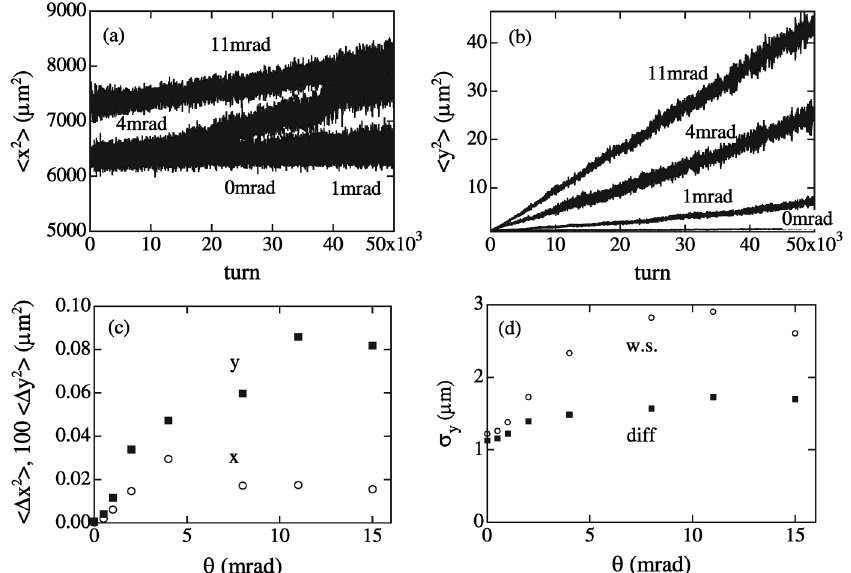
FIG. 5. Diffusion of horizontal and vertical beam size due to crossing angle. (a),(b) depict evolutions of horizontal and vertical beam sizes, respectively. (c) depicts the horizontal and vertical diffusion rates. (d) depicts vertical beam sizes, which are estimated by the diffusion rate (boxes) and are given by the weak-strong simulation with considering the synchrotron radiation (circles).